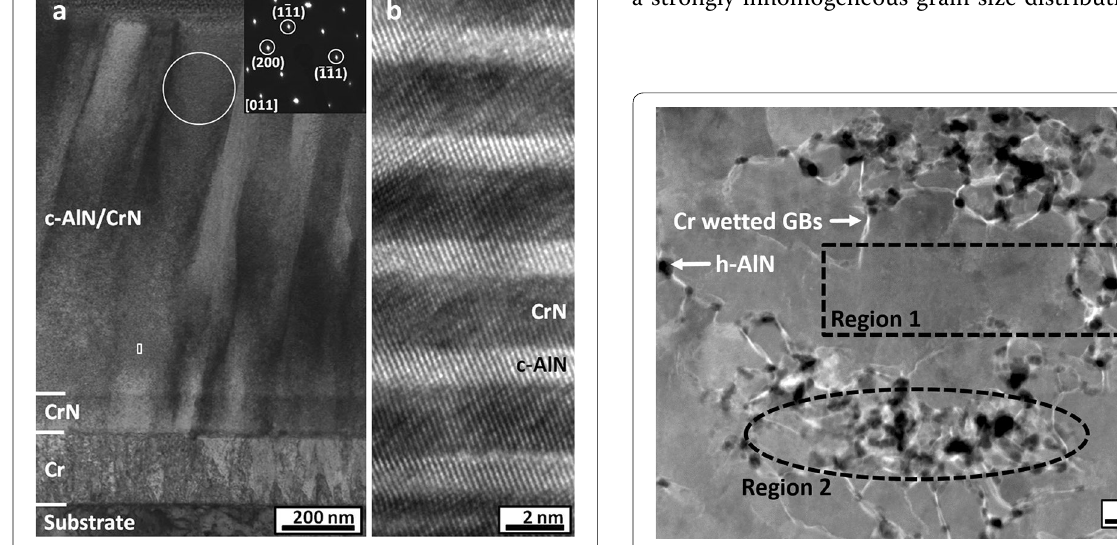
Fig. 2 In‑plain view of the c‑AlN/CrN multilayers annealed for 15 min at 900 °C acquired by STEM‑HAADF. The bright lines correspond to the CrN wetted columnar GBs. Hexagonal AlN (dark contrast) forms preferentially at GB junctions. Regions with low and high number densities of GB are apparent (Region 1 and 2,